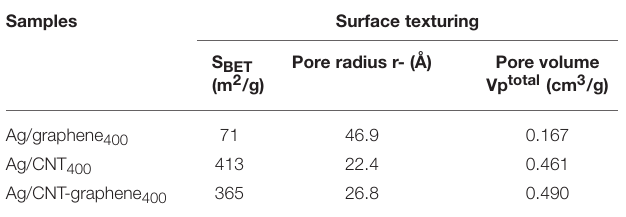
TABLE 1 | Surface texturing properties of the synthesized